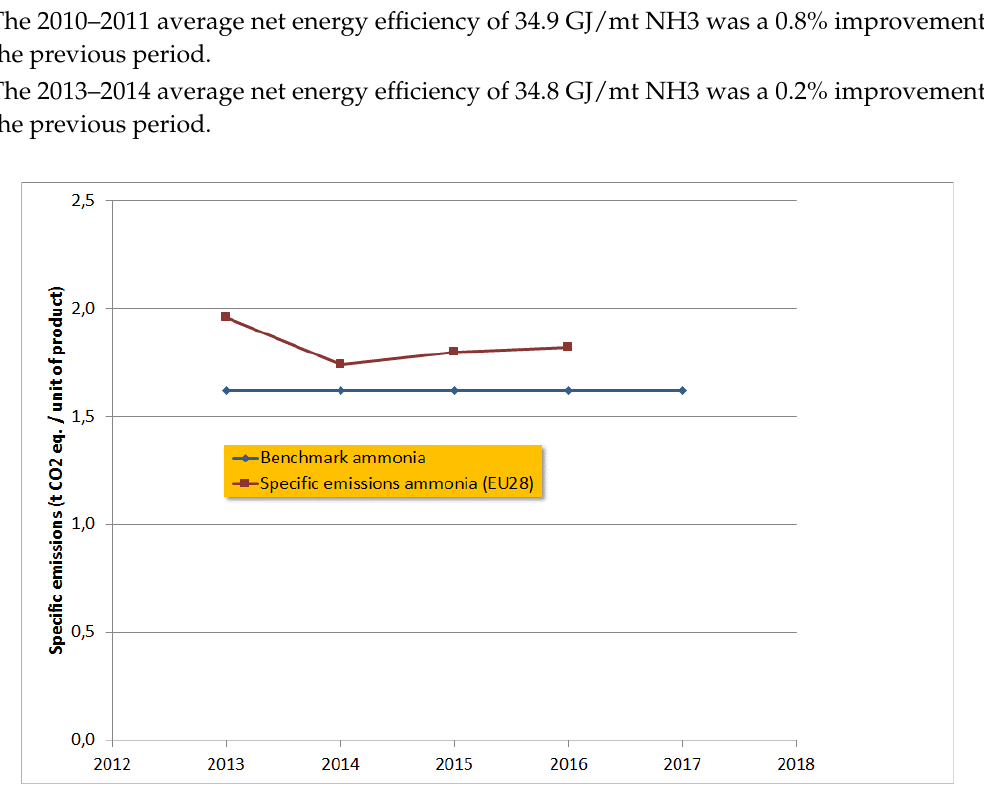
Figure 10. Specific emissions of ammonia compared to the benchmark (straight line). Source: Activity 41 (ammonia) [25]; Benchmark for ammonia [3]; Prodcom production data (code 20151075) [24].